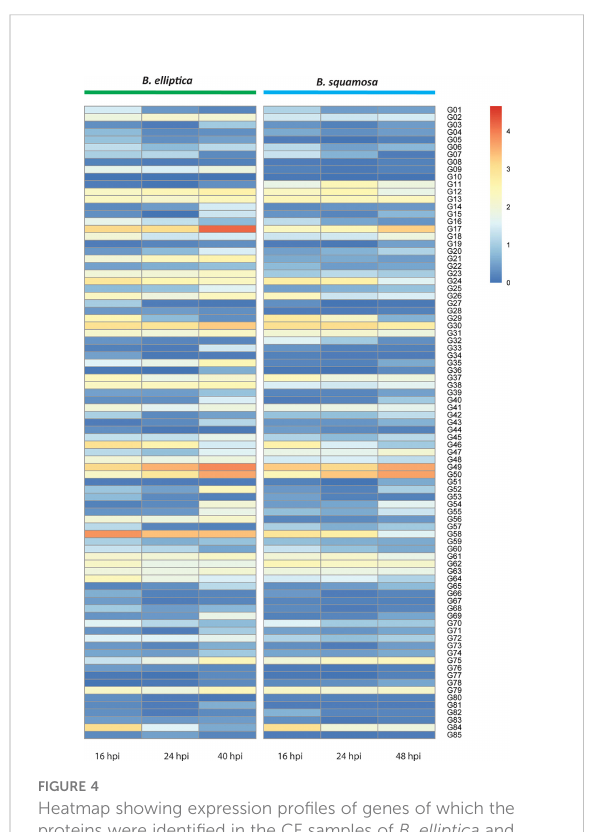
FIGURE 4 Heatmap showing expression pro fi les of genes of which the proteins were identi fi ed in the CF samples of B. elliptica and B. squamosa . Genes from both species that belong to the same orthogroups are aligned horizontally. Expression is based on the average of three replicate RNAseq samples during different timepoints of infection of B. elliptica and B. squamosa on their respective host